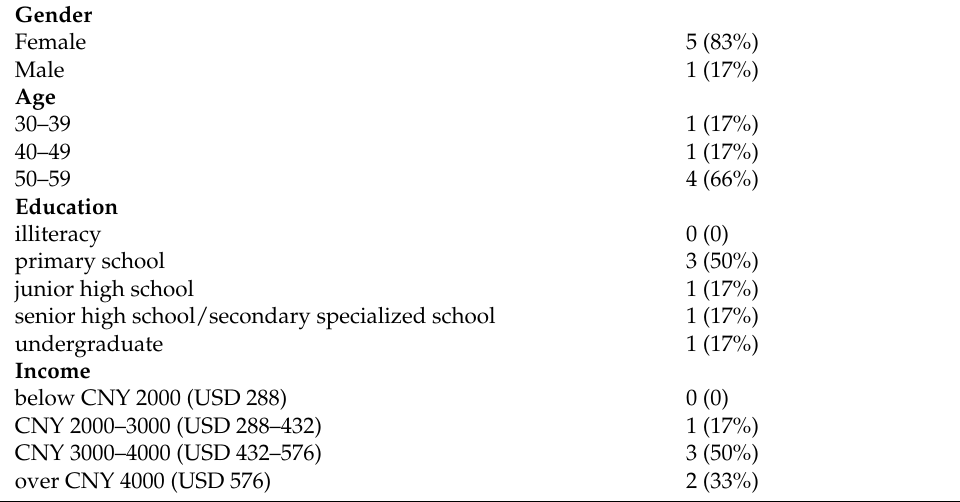
Table 2. Sample characteristics of the staff members (n =